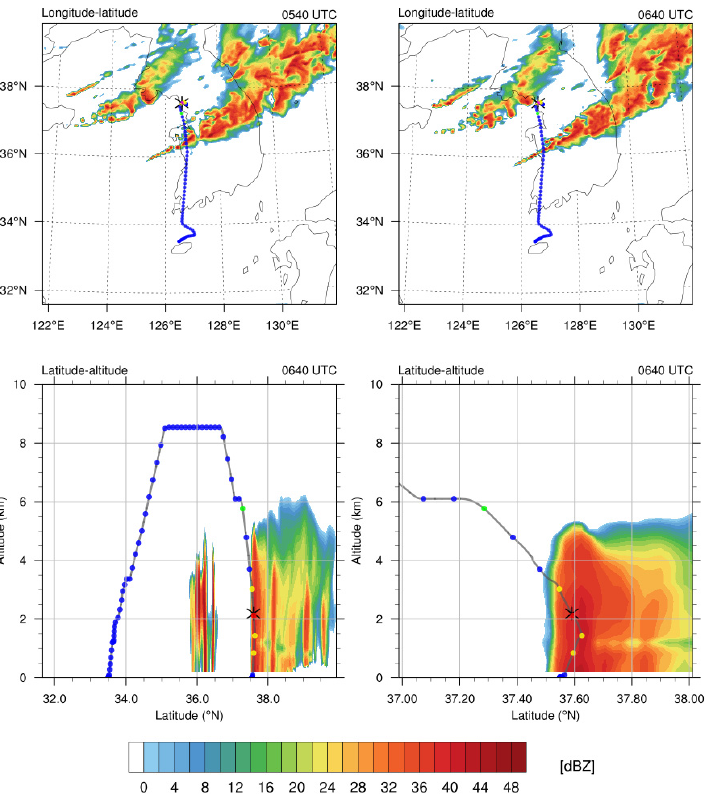
Figure 12. (Upper panels) Simulated column-maximum radar reflectivity at (left) 05:40 UTC and (right) 06:40 UTC on 28 October 2018 obtained from domain 2. (Lower panels) Latitude–altitude cross-sections of simulated radar reflectivity between 126 ◦ and 127 ◦ E at 06:40 UTC on 28 October 2018 for (left) entire latitude range of domain 2 and (right) magnified region. The location where the turbulence was encountered is indicated by the asterisk and the flight routes are indicated as dotted lines according to the EDR estimates (blue: NIL, green: LGT, yellow: MOD, and pink: SEV). In the latitude–altitude cross-sections of the simulated radar reflectivity at 06:40